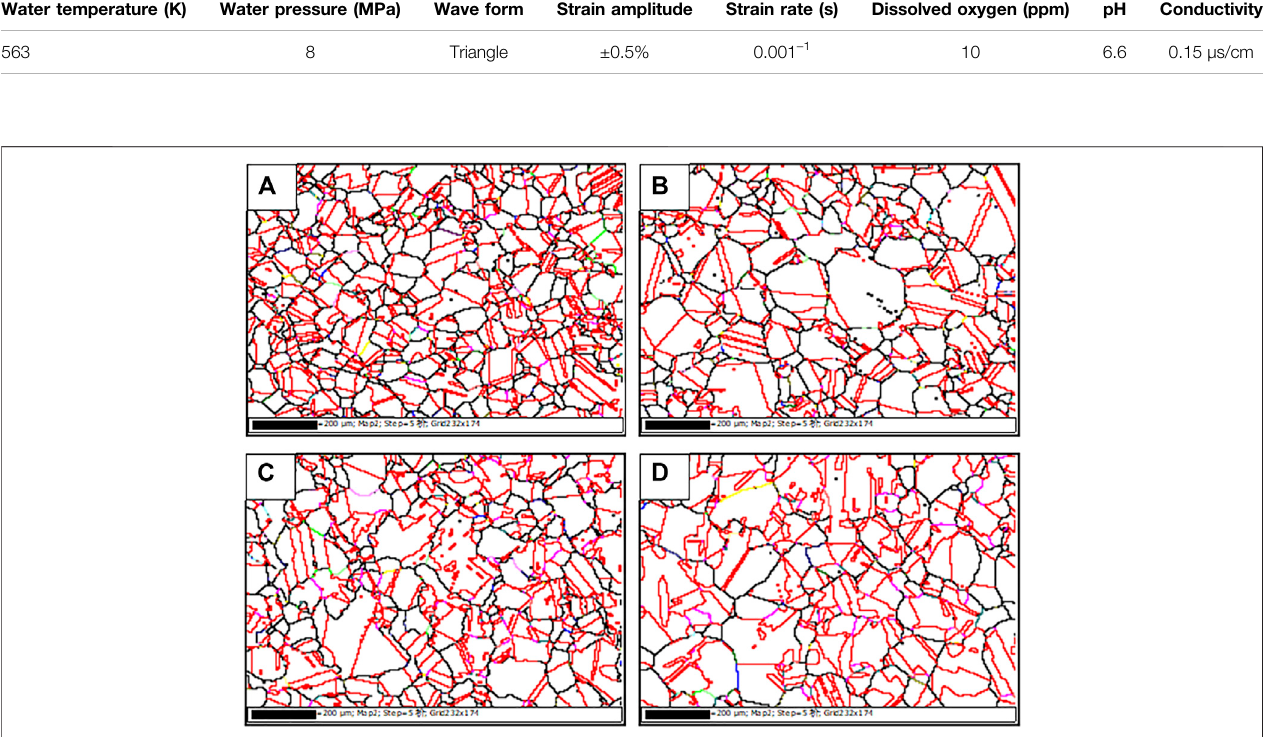
FIGURE 2 | GBCD of the (A) initial specimen and the GBE-treated specimens annealed for (B) 10 min, (C) 45 min, and (D) 90 min.